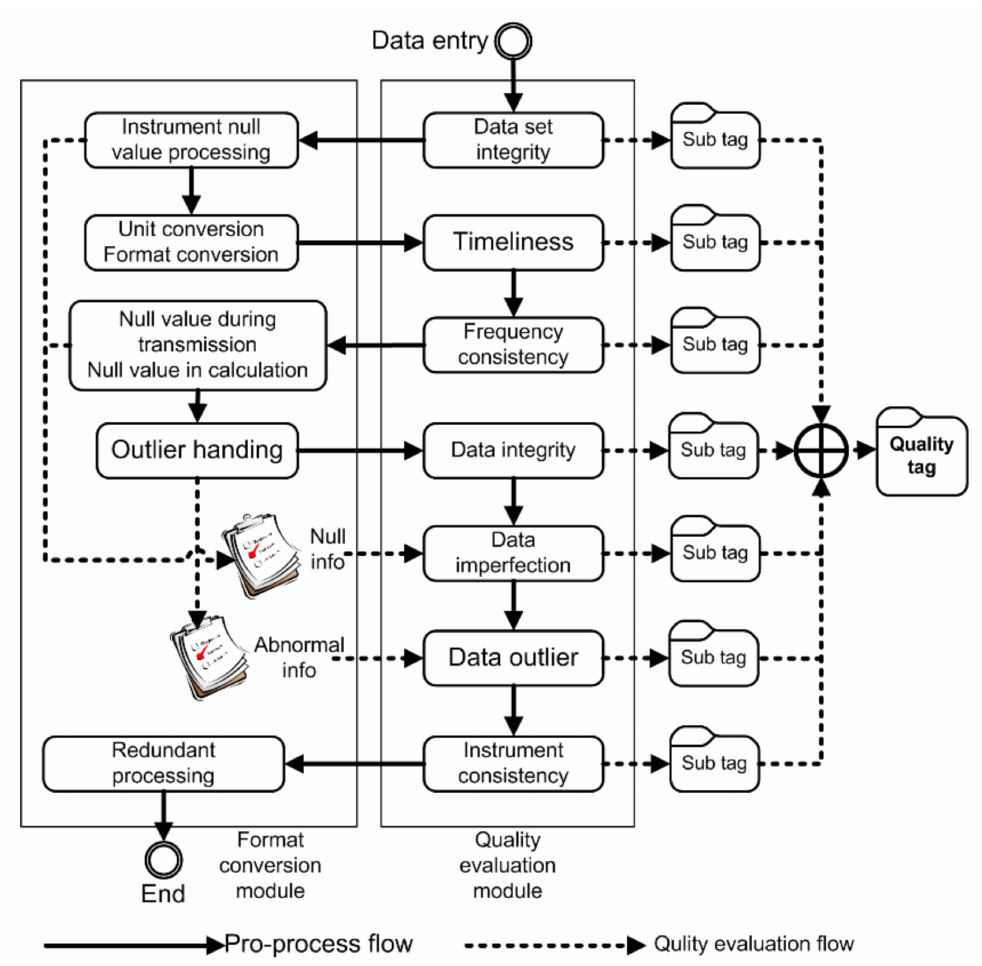
Figure 3. Data quality control items and flow in the